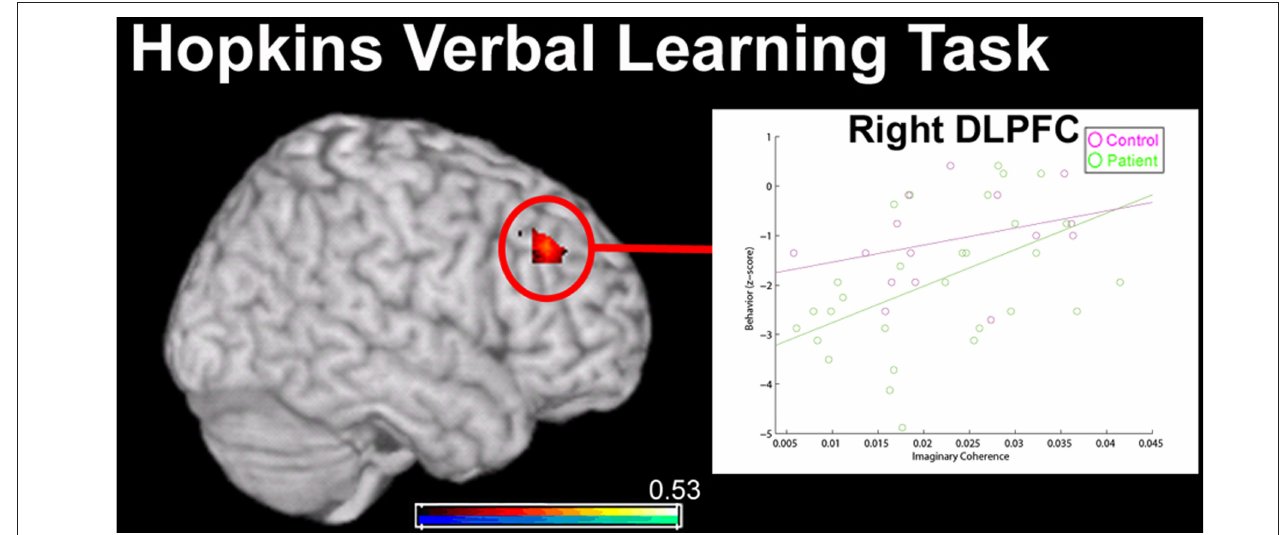
Figure  | relationship between Meg resting-state functional connectivity (imaginary coherence) data and performance on the Hopkins Verbal Learning Task (HVLT; delay component) in  healthy controls (in pink) and 0 patients with schizophrenia (in green). Global connectivity of a region in right dorsolateral pre-frontal cortex (DLPFC; over the middle frontal gyrus) was positively correlated